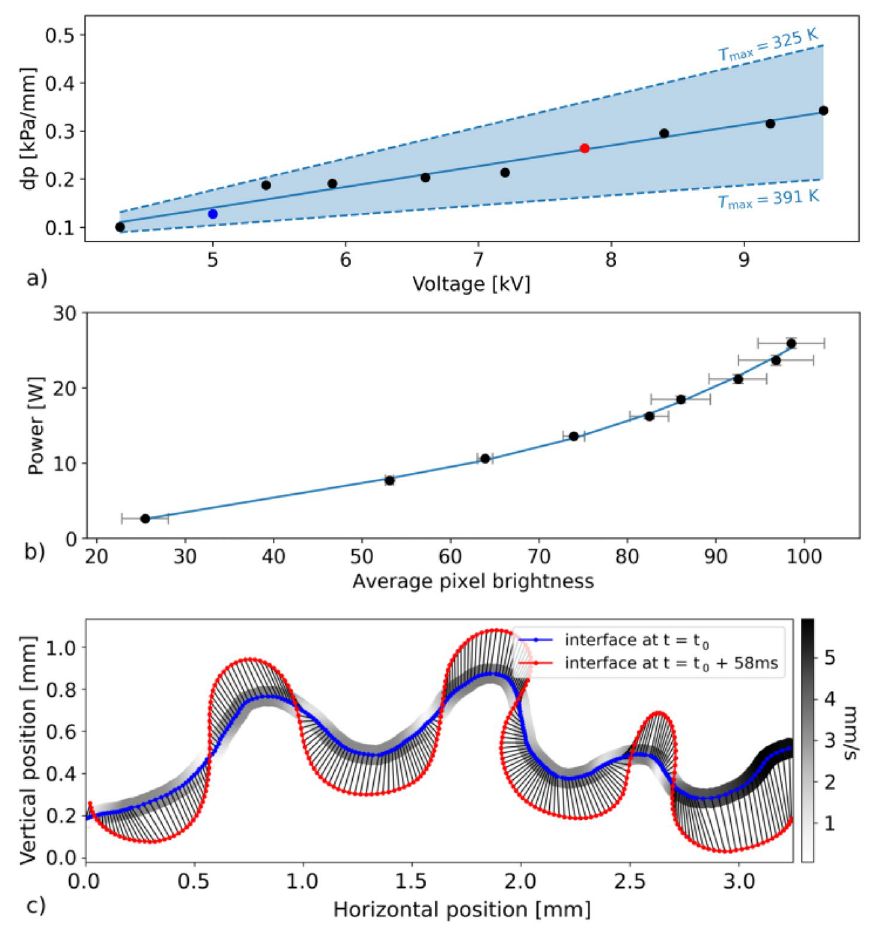
Figure 2. The elements of the developed methodology. ( a ) The accurate determination of the pressure gradient responsible for the microflow as obtained from Darcy’s law with temperature dependent viscosity. ( b ) The calibration curve showing the power in dependency on the pixel brightness of the ICCD images. ( c ) Determination of the local velocity of the plasma–liquid interface